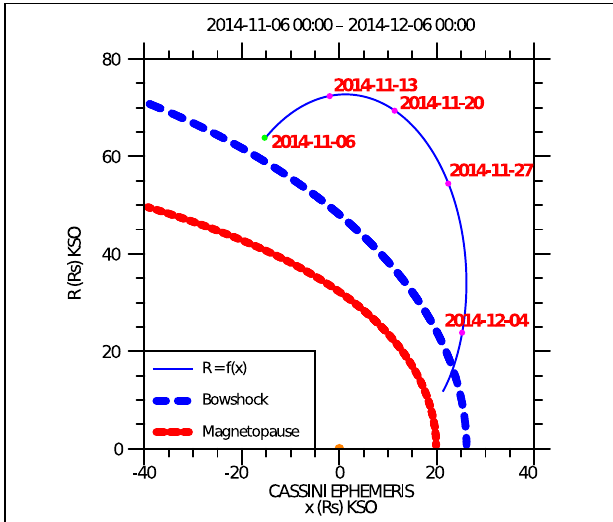
FIGURE 3 | Overview of the Cassini spacecraft trajectory on KSO (Kronian Solar Orbital) coordinates, as provided by AMDA. The radial distance R is displayed as a function of x KSO , for the Cassini trajectory and models of the magnetopause and bowshock. The modelled boundaries have been computed with a solar wind dynamic pressure of 0.05 nPa. We expect this value to have increased significantly during the ICME passage, which might explain why the boundary positions shown here don’t necessarily reflect the observed position of the boundaries. The pink and green dots along the trajectory are the location of Cassini at the labelled dates, the green location being the starting point.